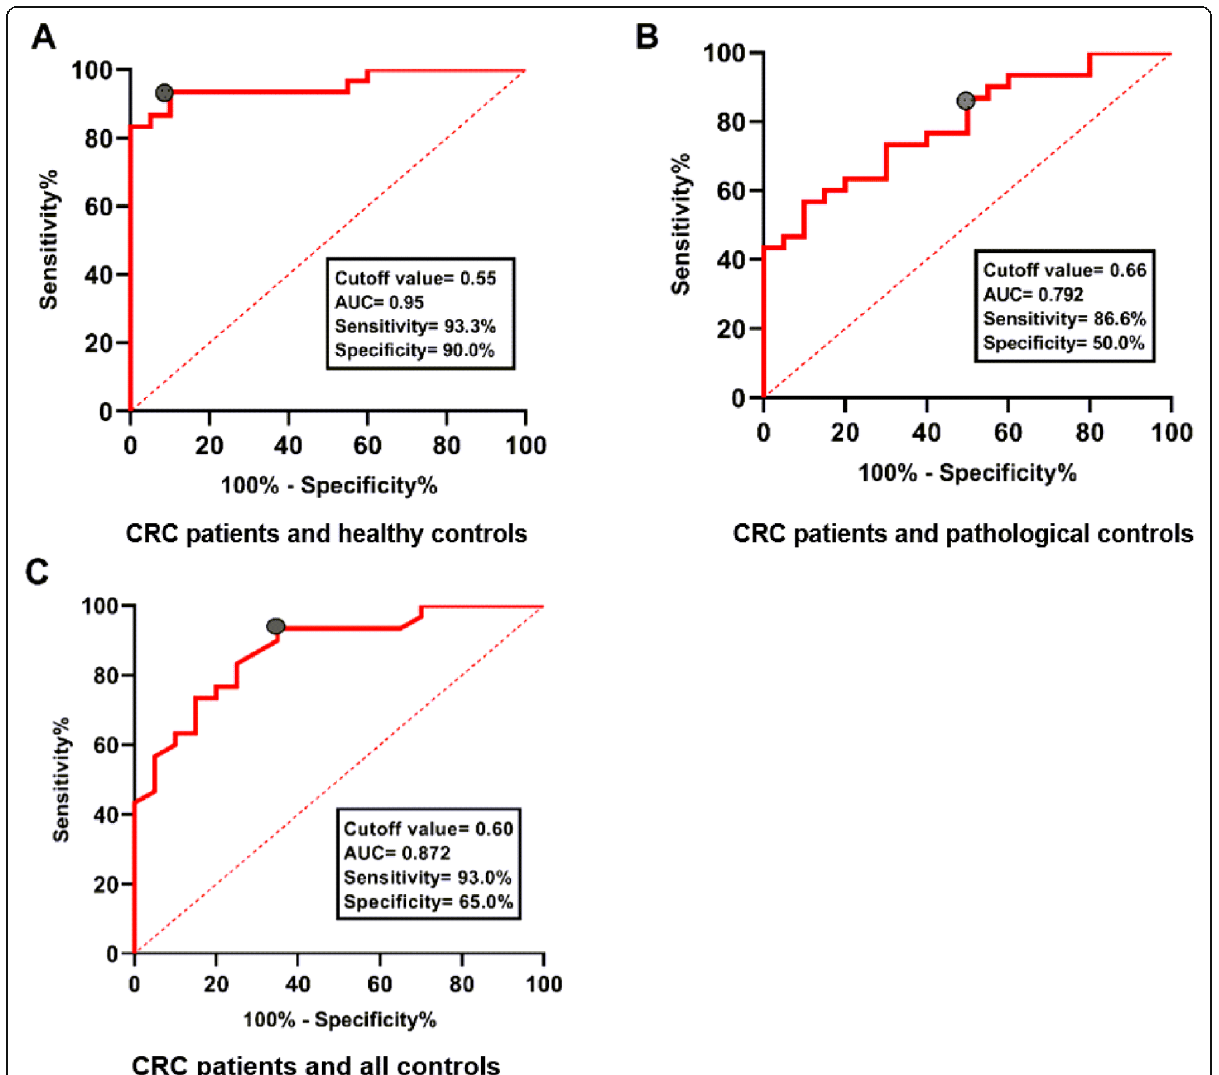
Fig. 5 ROC curve for DII for discriminating between CRC patients and healthy controls ( a ), CRC patients and pathological controls ( b ), and CRC patients and all controls ( c